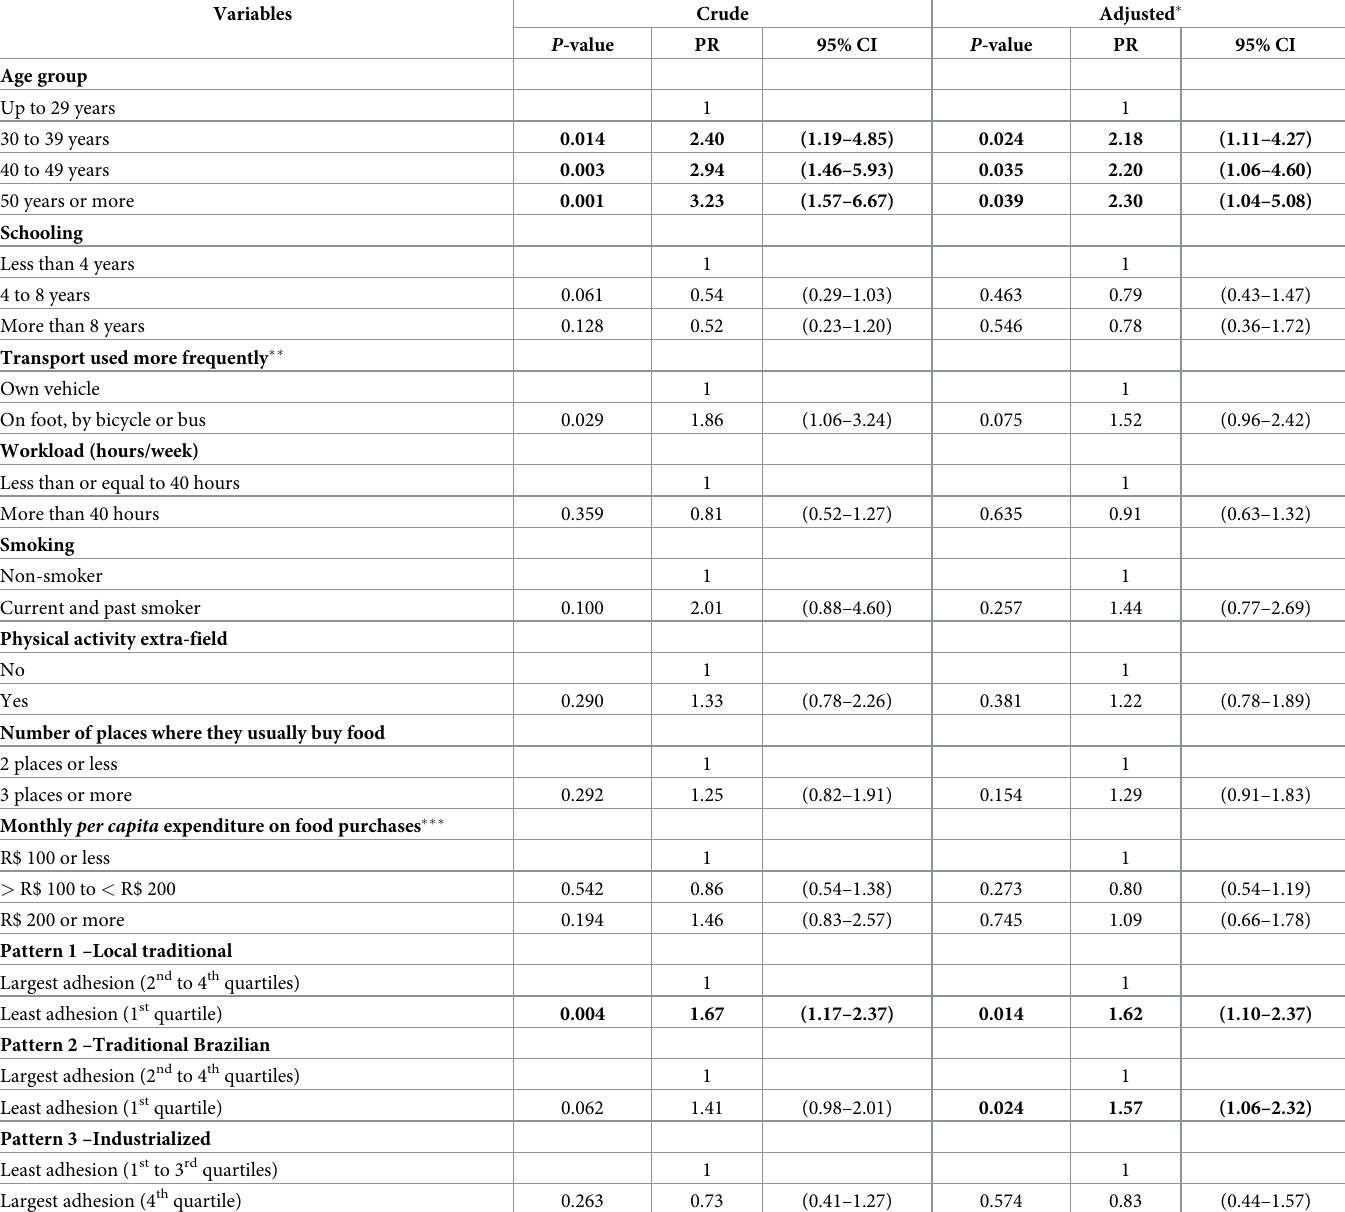
Table 7. Factors associated with general obesity among women in a rural Brazilian